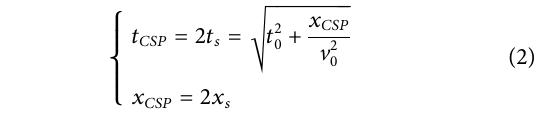
Frontiers in Earth Science |